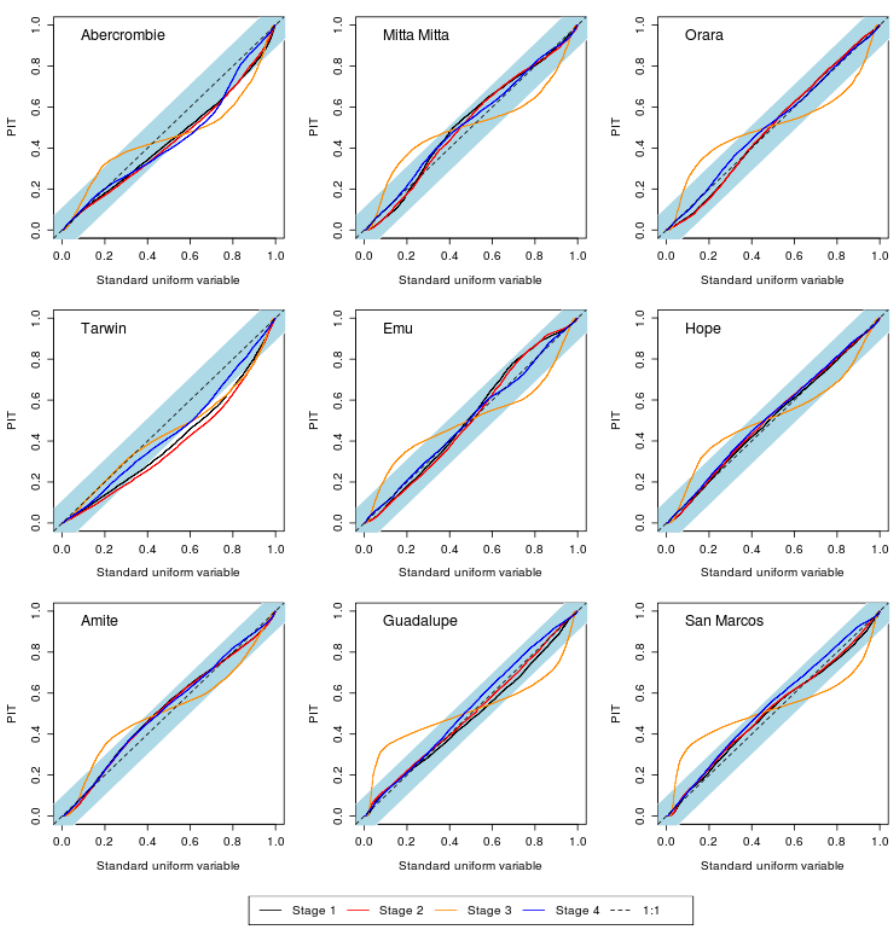
Figure 4. Comparison of the cumulative probability distribution of the PIT at different stages (light-blue shaded strips indicate the 95% significant band of the Kolmogorov–Smirnov